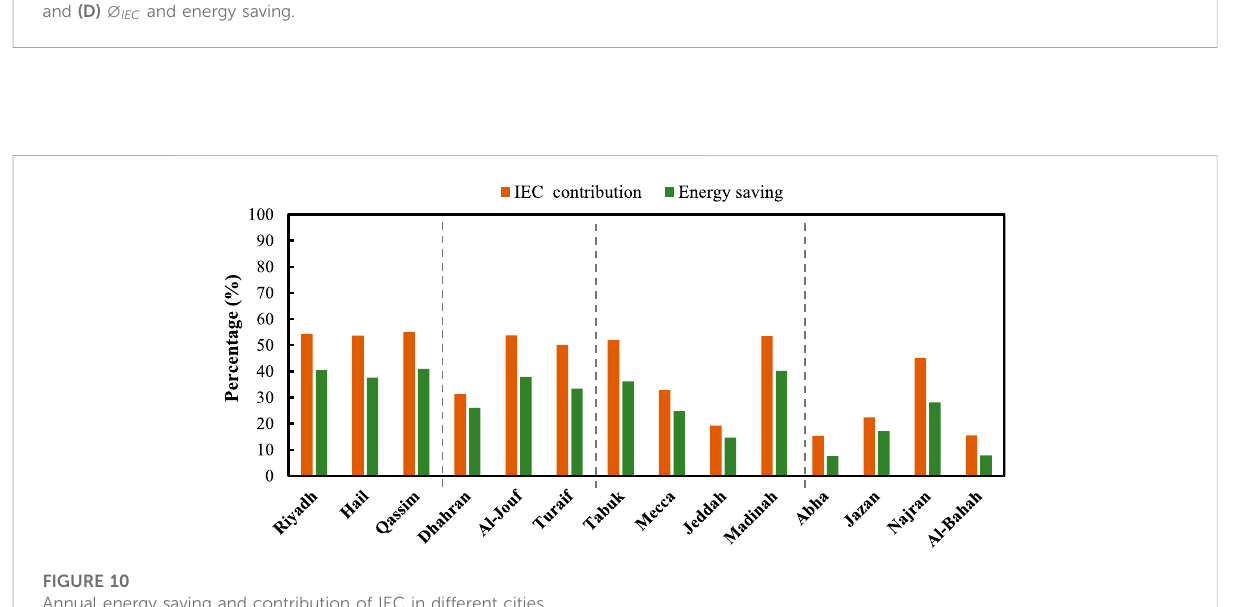
FIGURE 10 Annual energy saving and contribution of IEC in different